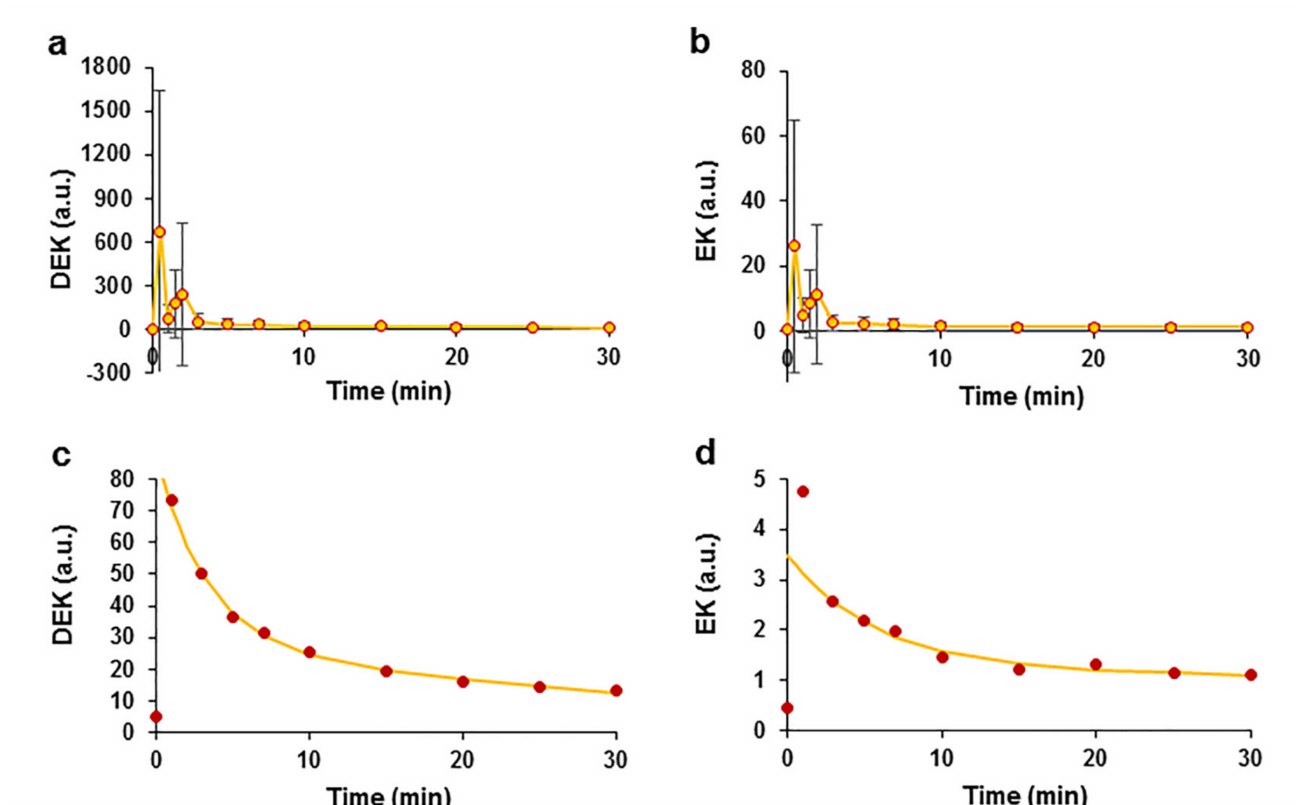
Figure 5. Pharmacokinetics of the E. ciliata ketones DEK and EK after intravenous administration of the EO bolus in swine. Time courses of DEK ( a ) and EK ( b ) in auxiliary units. The kinetics of decreases in the DEK ( c ) and EK ( d ) concentrations were approximated using the double exponential function (lines) (the same data as in ( a , b ) are shown at higher magnification), (circles)—experimental points indicate concentrations in a.u. ( a – d ), n =